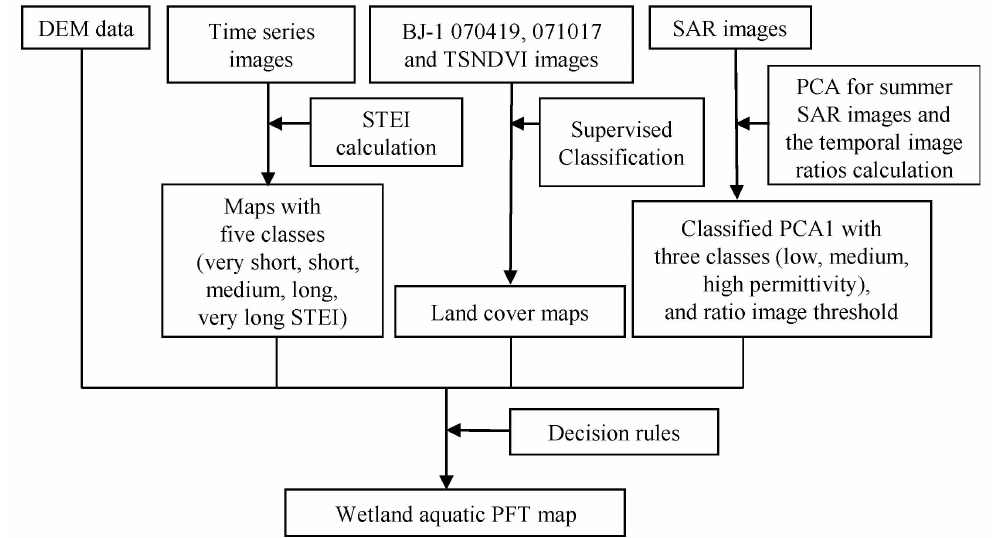
Figure 6. Flowchart of rule-based plant functional type (PFT) classification over Poyang Lake. STEI, submersion time estimation index; PCA, principal component analysis. Summer SAR images are ASAR images acquired on 29 June, 31 July, and 4 September 2007. Temporal image ratio refers to ratio between ASAR WSM images acquired on 10 June 2007 (WSM070610) and 29 June 2007